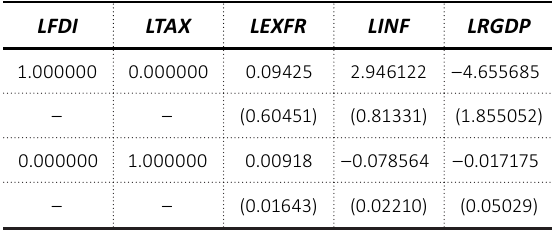
Table 6. Normalized co-integrating coefficient (standard error in